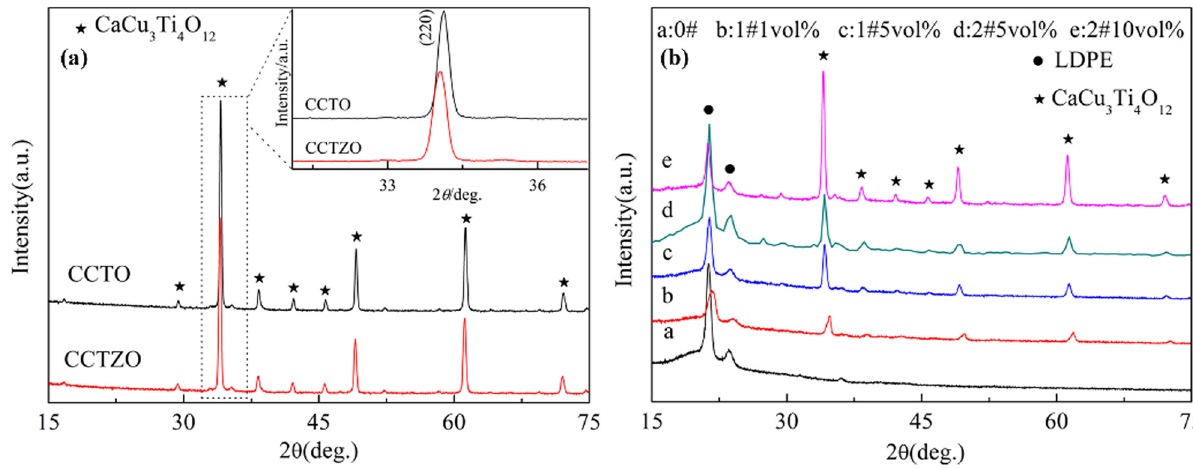
Figure 1: ( a ) XRD patterns of the CCTO and CCTZO ceramics; the inset is image magni fi cation. ( b ) XRD patterns of the CCTO/LDPE and CCTZO/LDPE